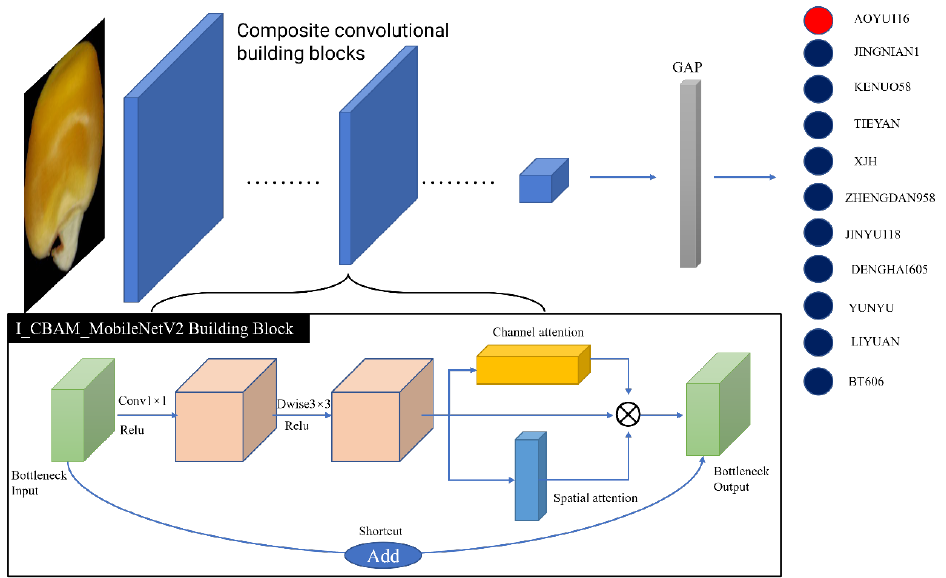
Figure 6. I_CBAM_MobileNetV2 overall architecture.